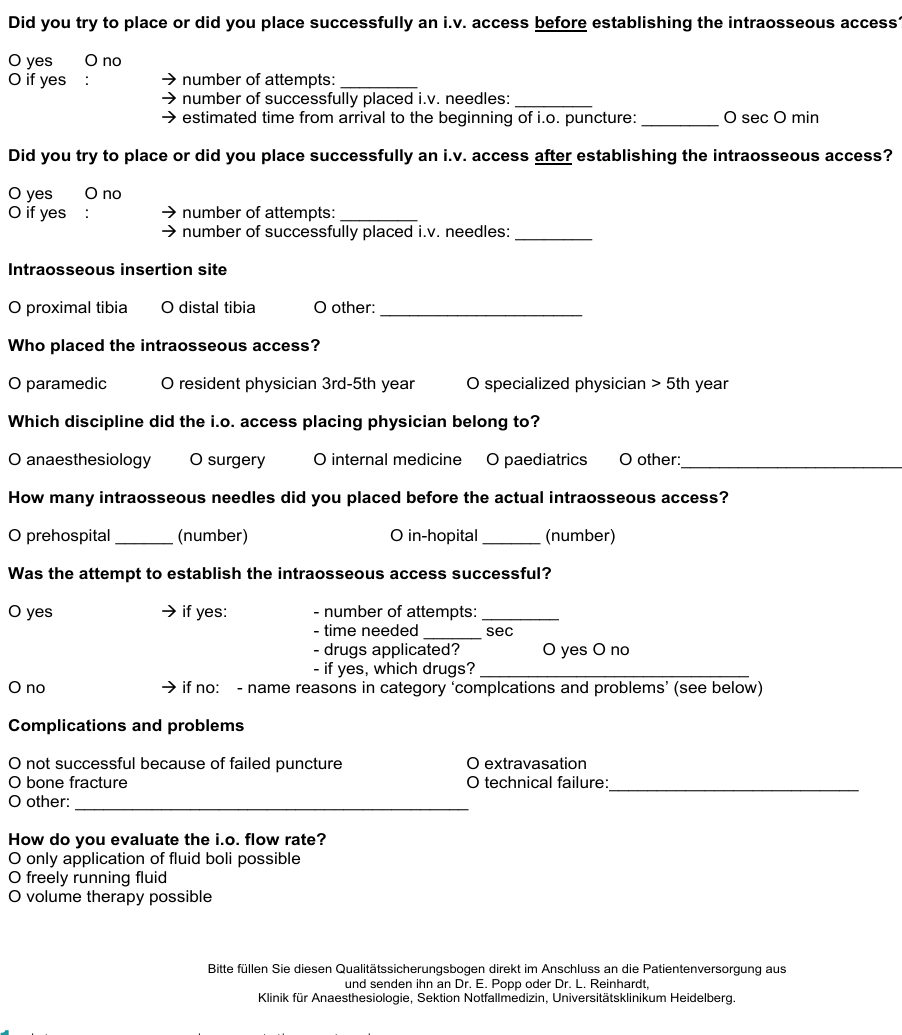
Figure 1. Intraosseous access documentation